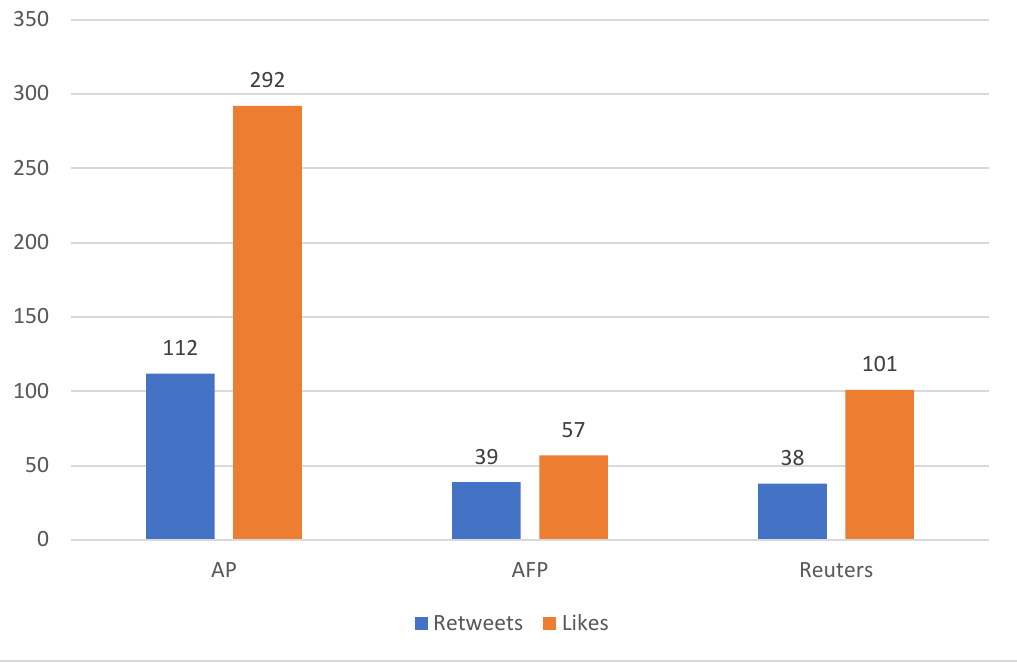
Figure 2. The median number of retweets and likes in the three news agencies’ Twitter accounts.